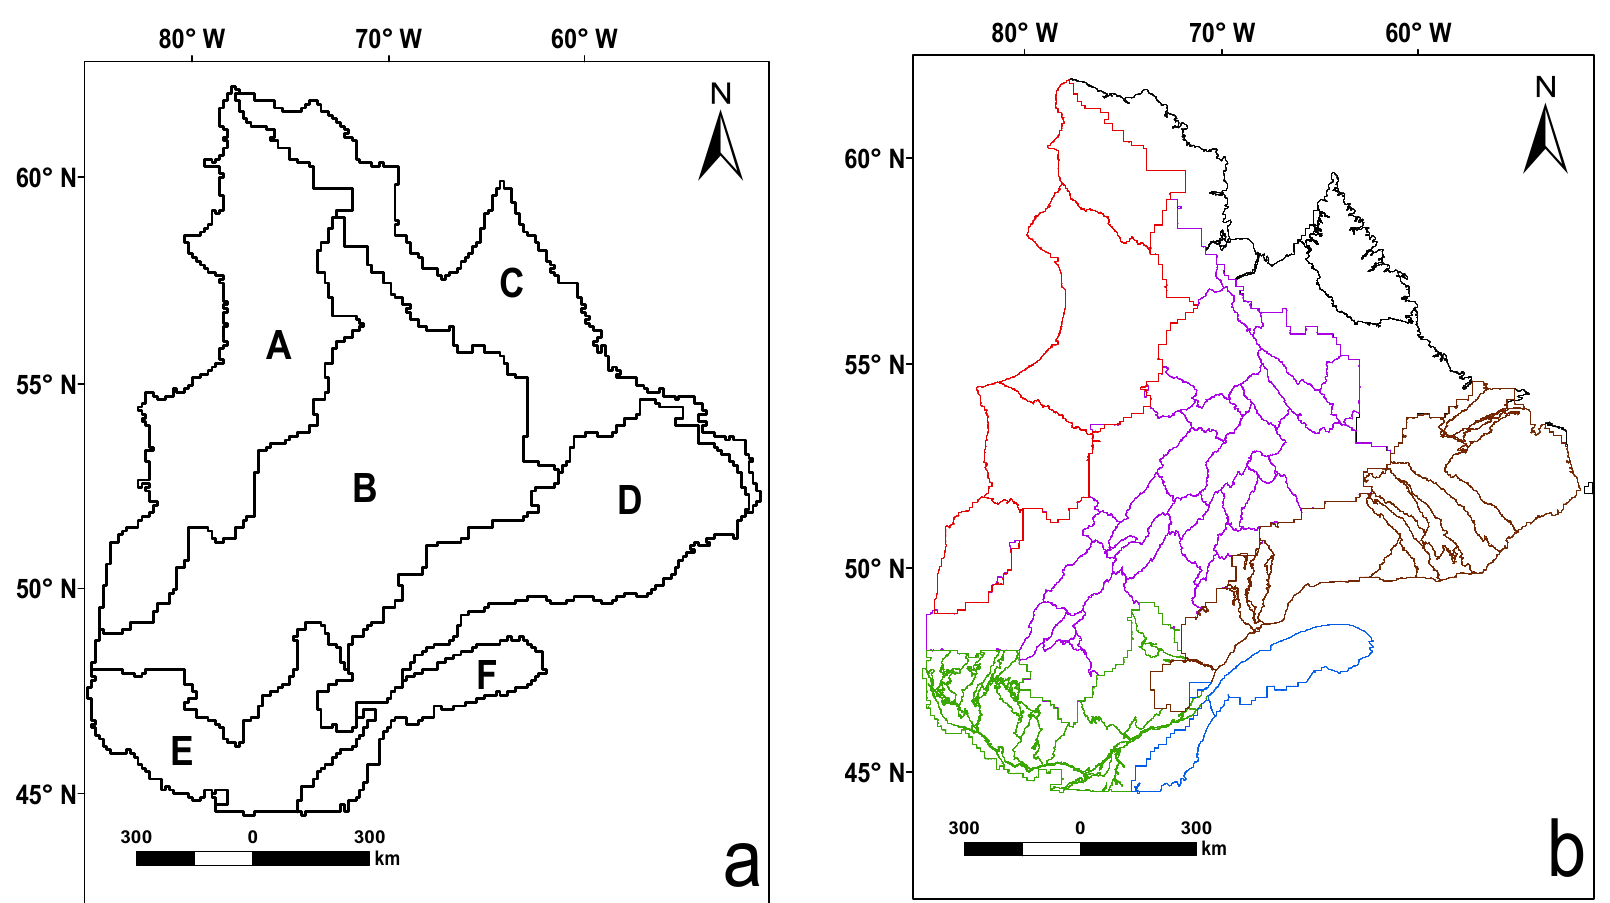
Figure 2. Zones and geographical units of homogeneous snow water equivalent (SWE) spatial structures obtained by the functional method at regional scale ( a ) and local scale ( b ).